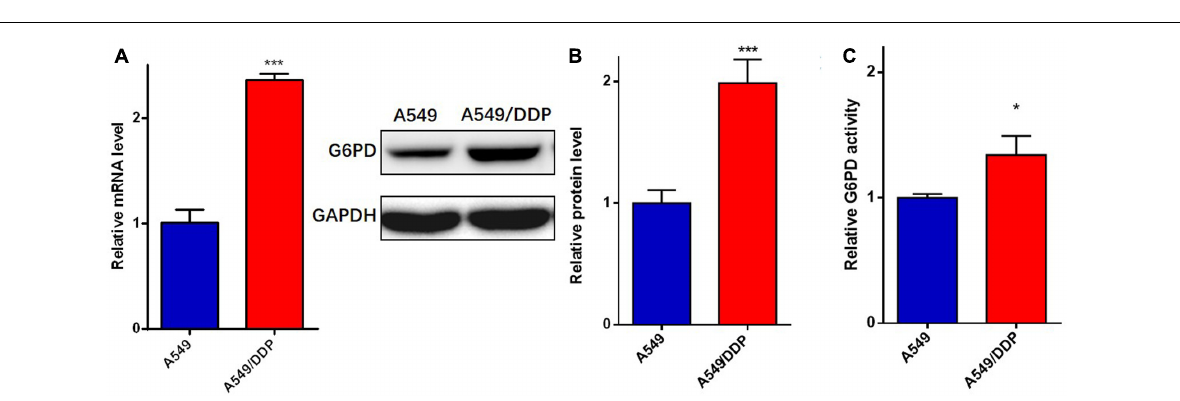
FIGURE 2 | The redox status of A549/DDP cells was different from that of A549 cells. The (A) GSH, (B) NADPH/NADP + , and (C) ROS level were measured in A549 and A549/DDP cells. Data are represented as the means ± SD ( n = 3), and significant differences are indicated as ∗ P < 0.05, ∗∗ P < 0.01, and ∗∗∗ P < 0.001.